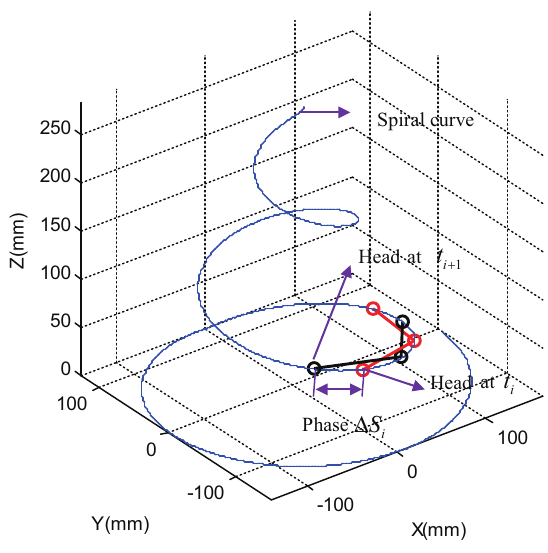
Figure 4. Concepts of shape-fitting and